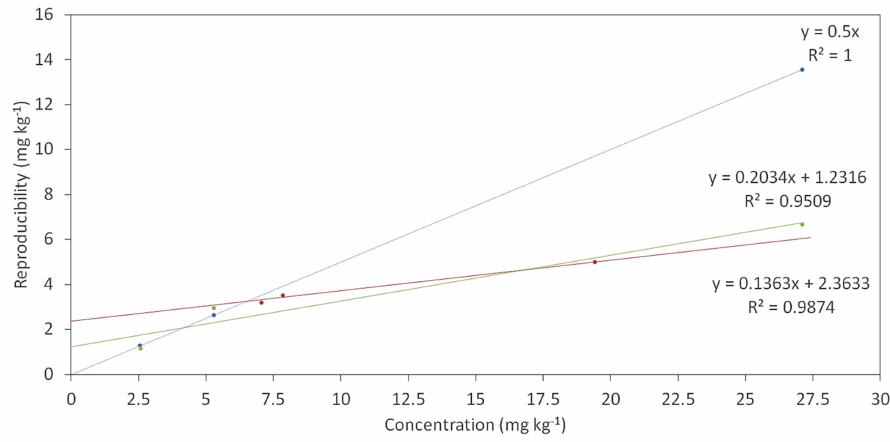
Figure 8. Reproducibility vs. mean Cr (VI) concentration plots: colorimetric method (red), chromato- graphic method (green), 50% error calibration (blue).